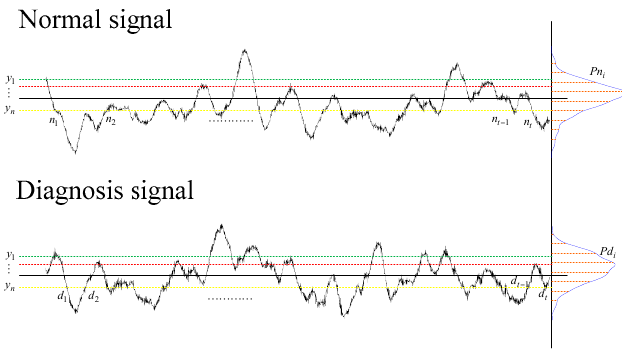
Figure 7. Statistical information criterion schematic diagram.